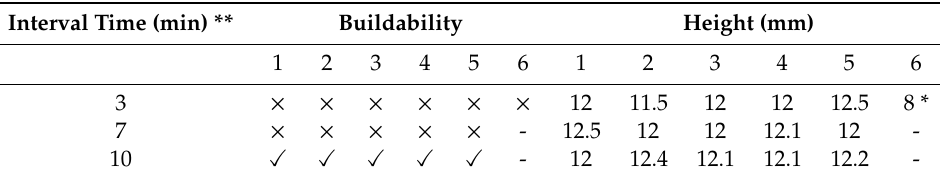
Table 6. Caulking gun extrusion nozzle (Ø14 mm).